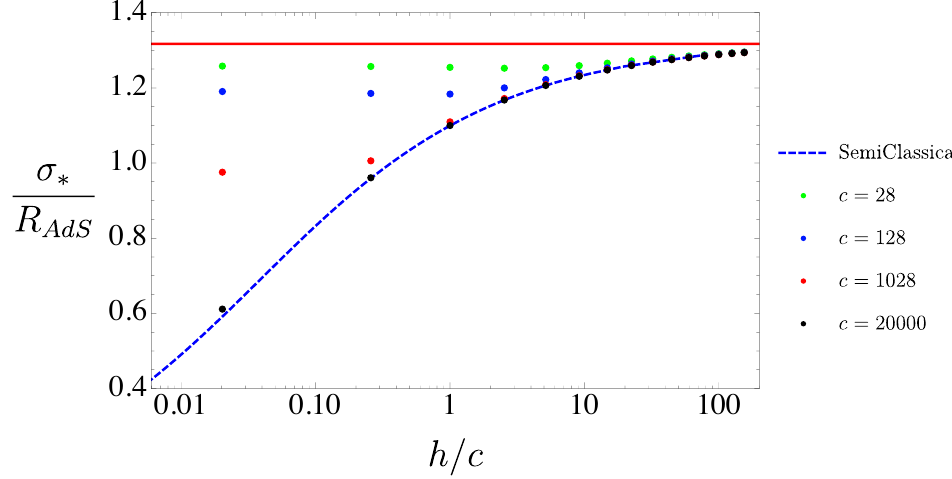
Figure 6 . This (cid:12)gure displays the scale at which the propagator breaks down as we approach the semiclassical limit; for each value of c , we’ve taken a range of values for the ratio h extracted in the same way as in (cid:12)gure 5. We see that at large h we approach the convergence bound (cid:27) = R AdS log(2 + p 3) from the exact result of section 3.3. We have also shown ( blue, dashed ) the (cid:3) result from the numeric semiclassical computation in section 3.4, and (cid:12)nd that it agrees with the radius of convergence analysis for the large c (= 20,000) points shown